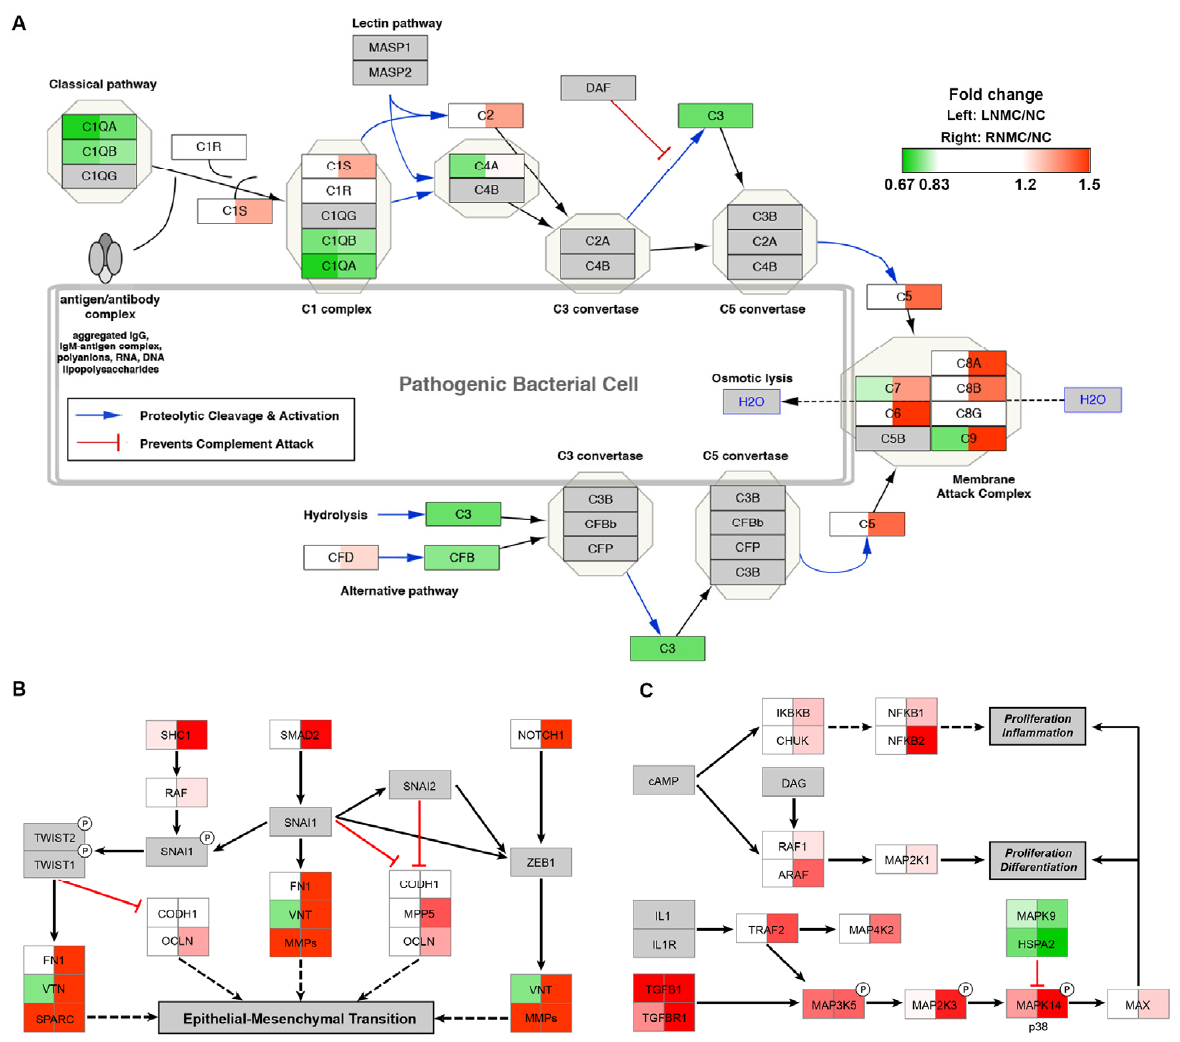
Figure 3. Pathways enriched in the RNMC-specific DEPs. MS data presented as the 130/126 (left) and 131/126 (right) ratios. Up or downregulation of identified proteins is indicated by colors in the pathway (upregulated in red, downregulated in green). ( A ) The DEPs mapped to the complement activation pathway. ( B ) The DEPs mapped to EMT in the CRC pathway. ( C ) The DEPs mapped to the MAPK signaling pathway. The protein abundance of tumor tissue relative to normal tissue is indicated in different colors, with red indicating up-regulated protein and green indicating down-regulated protein.